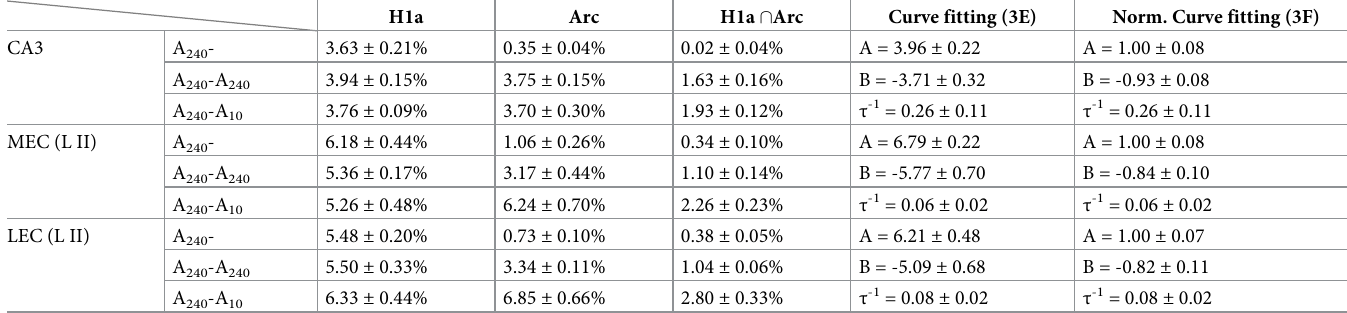
Table 2. Descriptive statistics of H1a/Arc ensembles in Fig